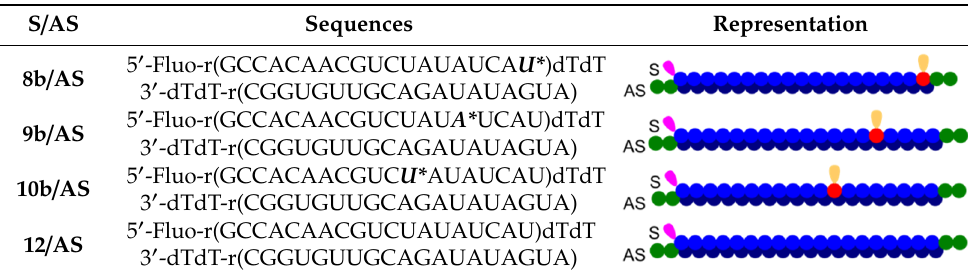
Table 3. 2’-cholesterol-conjugated siRNA used in this study.